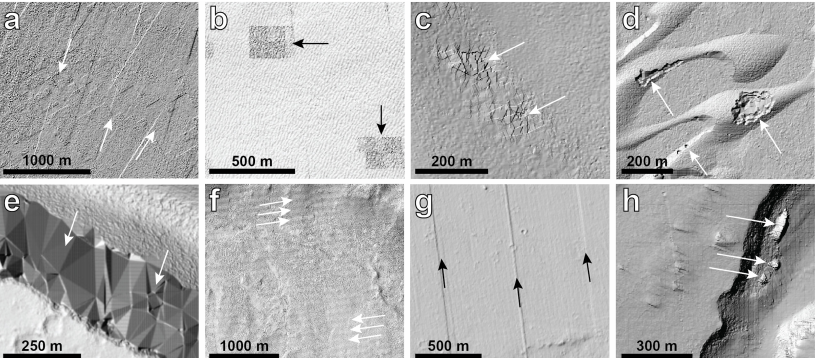
Figure 4. Examples of typical artifacts found in HiRISE DTMs, shown in terrain shaded relief maps, which emphasize the surface texture of the model. In all panels illumination is from upper left, with north oriented to the top of the page. Arrows indicate artifacts. ( a ) Tiling “boxes” typical of NGATE, and linear artifacts along CCD seams (DTEPC_009689_2645_010084_2645). ( b ) Isolated noisy boxes possibly due to jitter (DTEEC_057321_1220_057453_1220_A01). ( c ) Triangular facets in an area of deep shadows in the stereo images (DTEPC_041121_0985_041029_0985_A01). ( d ) Areas of failed stereo correlation over dark dunes with ripples that were active between the acquisition of the two stereo images (DTEEC_050438_1890_051071_1890_A01). ( e ) Large triangular facets due to deeply shadowed areas with differing shadow boundaries, as well as an obscured surface in one image due to viewing geometry (DTEEC_069071_2020_063847_2020_A01). ( f ) Ripple pattern characteristic of jitter in the cross-track direction (DTEEC_039216_1835_039849_1835_A01). ( g ) Linear features along CCD seam boundaries due to along-track jitter (DTEED_063209_1800_063420_1800_A01). ( h ) Artifacts typical of those that occur where dark shadow boundaries shifted between stereo image acquisitions